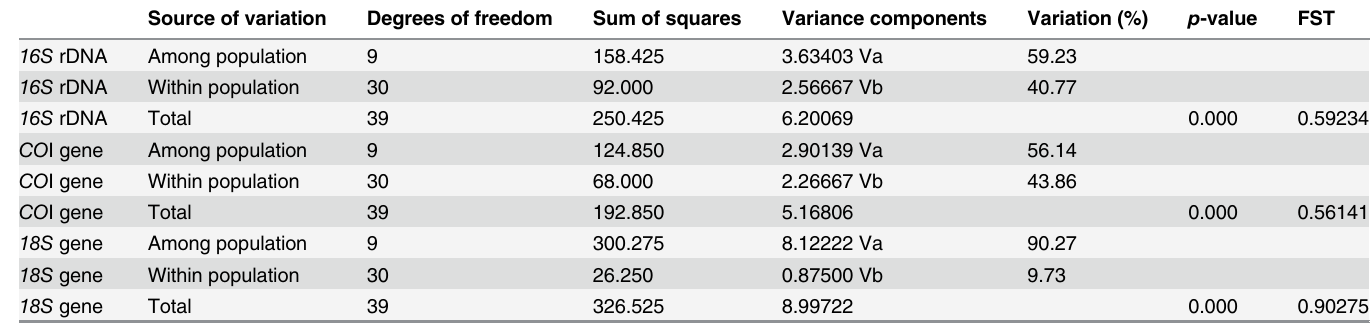
CO I gene Total